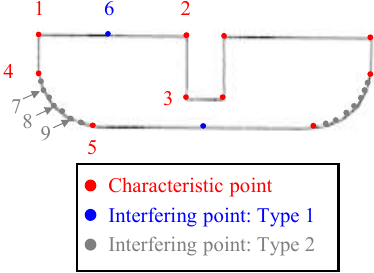
Figure 7. Schematic diagram of the characteristic points and interfering points.